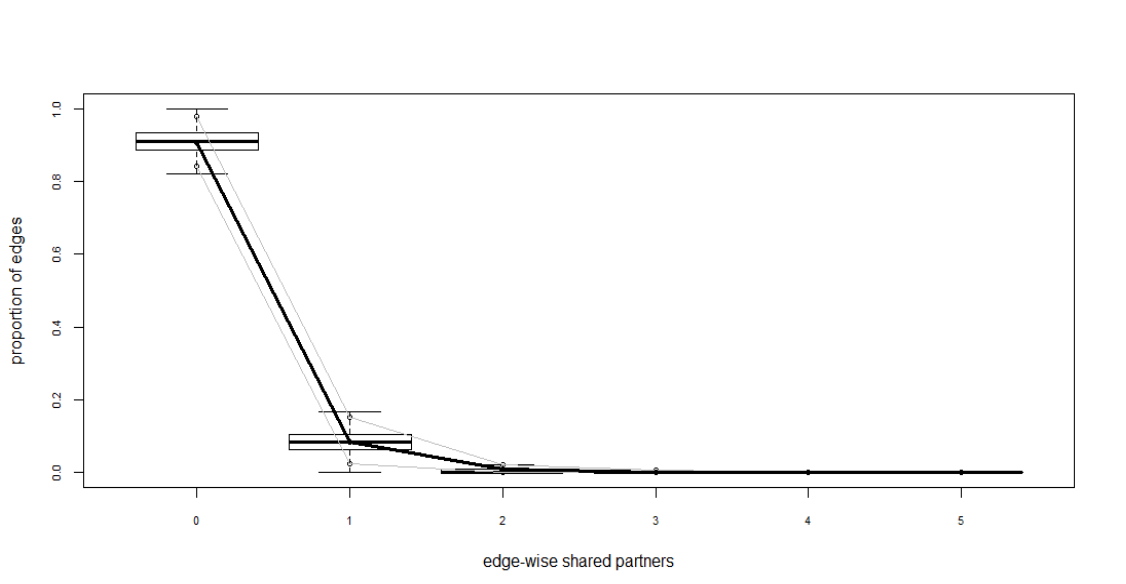
Figure A1.2 Goodness of Fit Diagnostics for Edge-Wise Shared